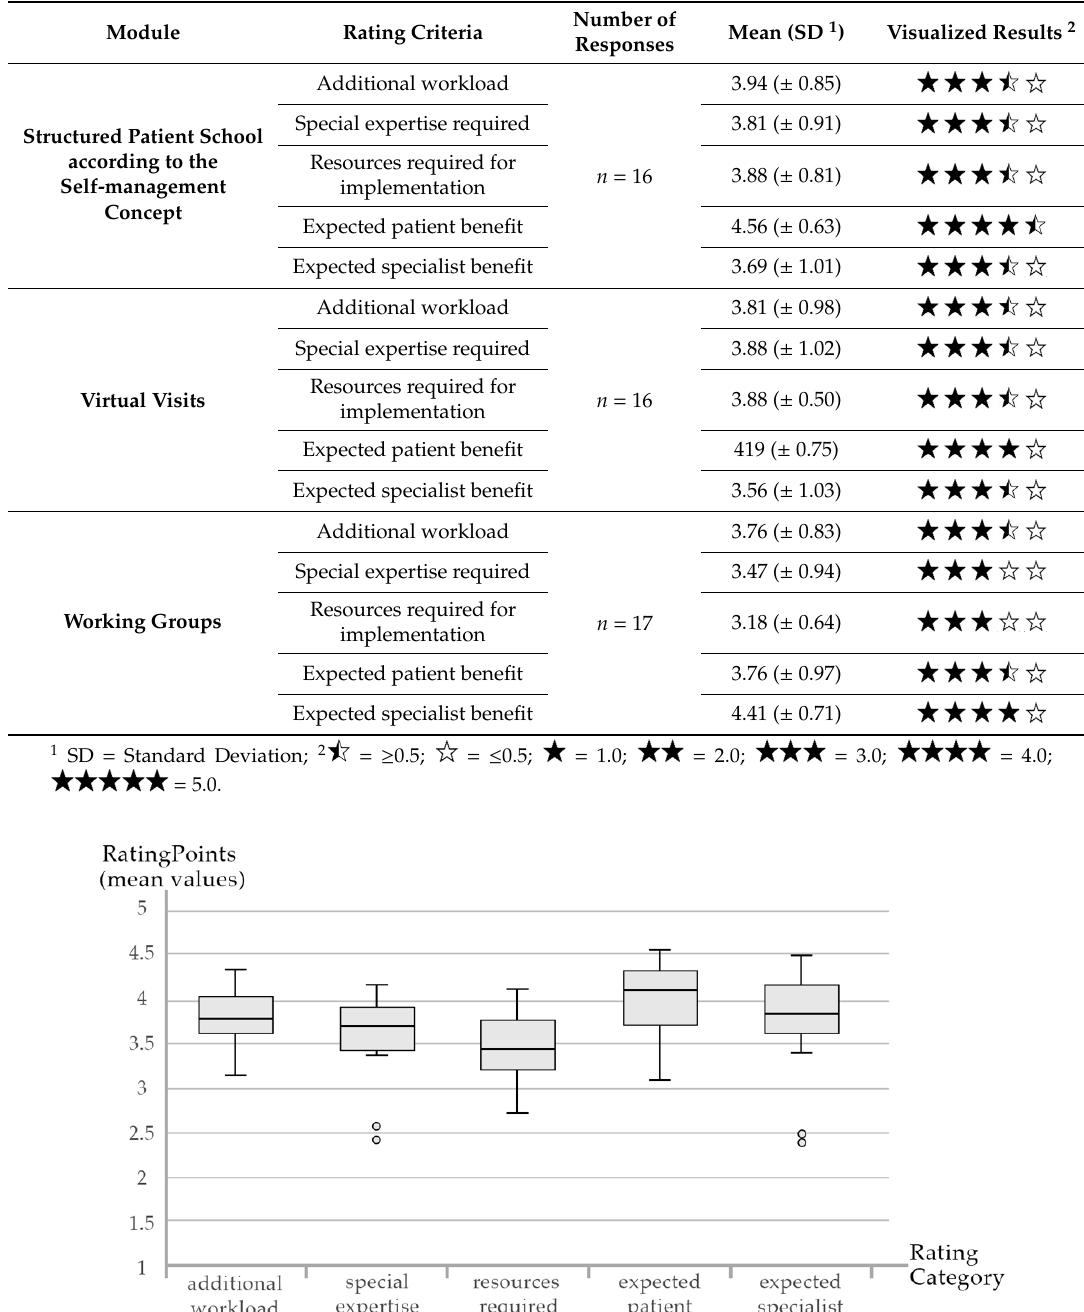
Figure 3. Box Plots for the Rating Categories and Rating Values (Modules: n = 25, Raters: n = 17) .